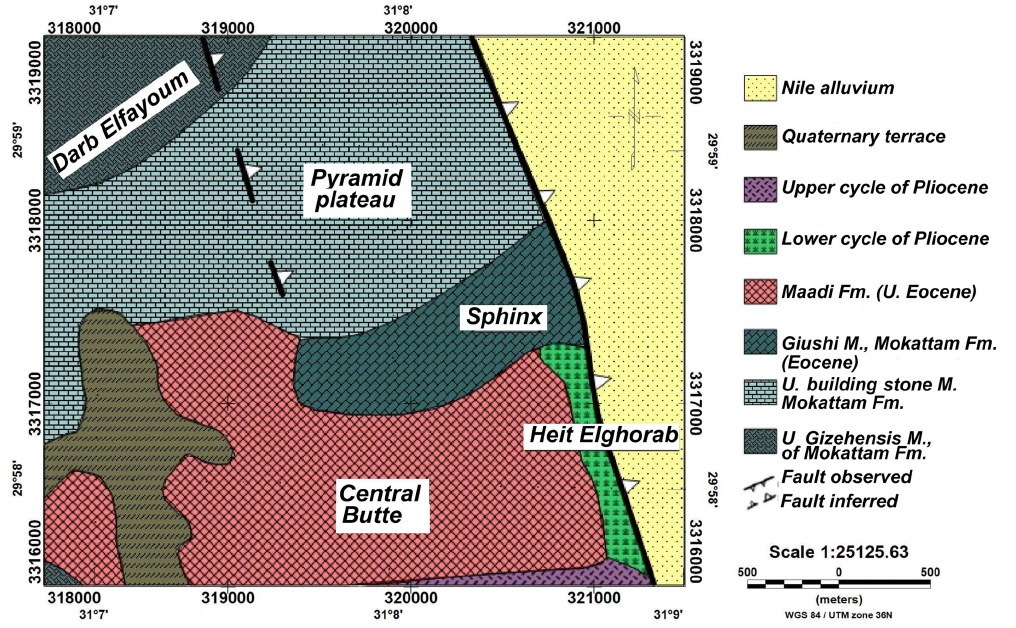
Figure 2. Geologic map of the Giza Plateau, Egypt (modified after Yehia, 1985).